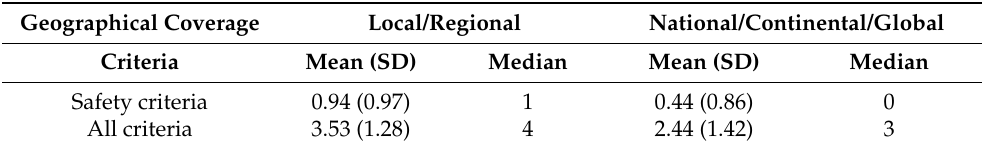
Table 3. Number of safety related criteria and all routing criteria, analyzed for routing portals that operate on different levels of geographic